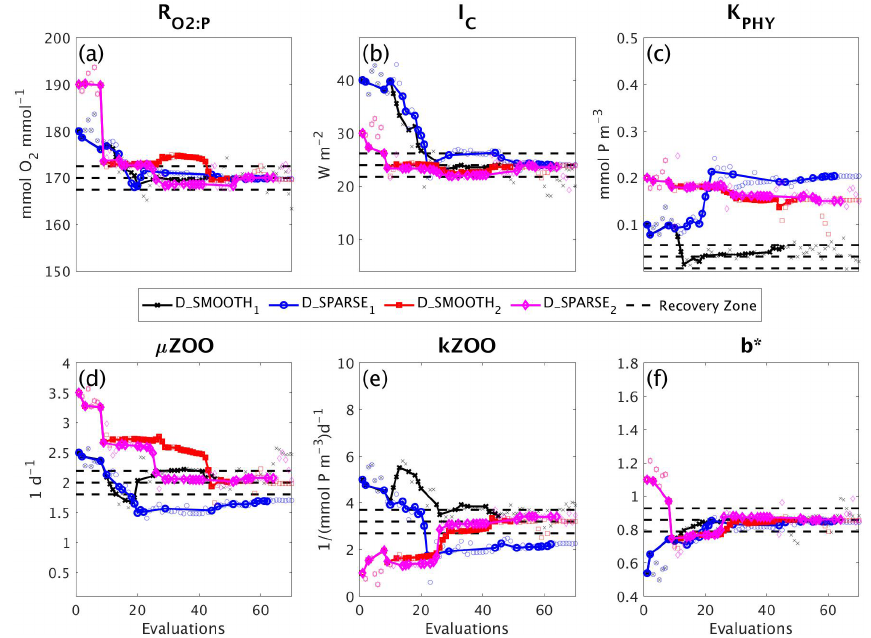
Figure 13. As in Fig. 9, but for the experiments D_SMOOTH 1 (black line with crosses), D_SPARSE 1 (blue line with circles), D_SMOOTH 2 (red line with squares) and D_SPARSE 2 (magenta line with